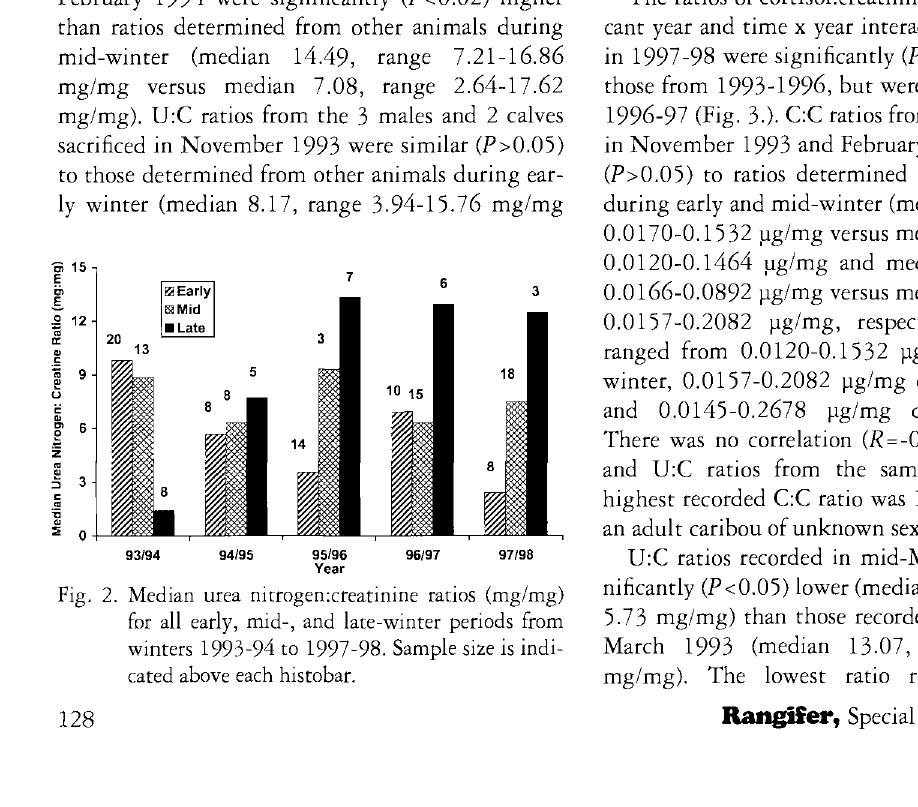
Fig. 2. Median urea nitrogenxreatinine ratios (mg/mg) for all early, mid-, and late-winter periods from winters 1993-94 to 1997-98. Sample size is indi cated above each histobar.